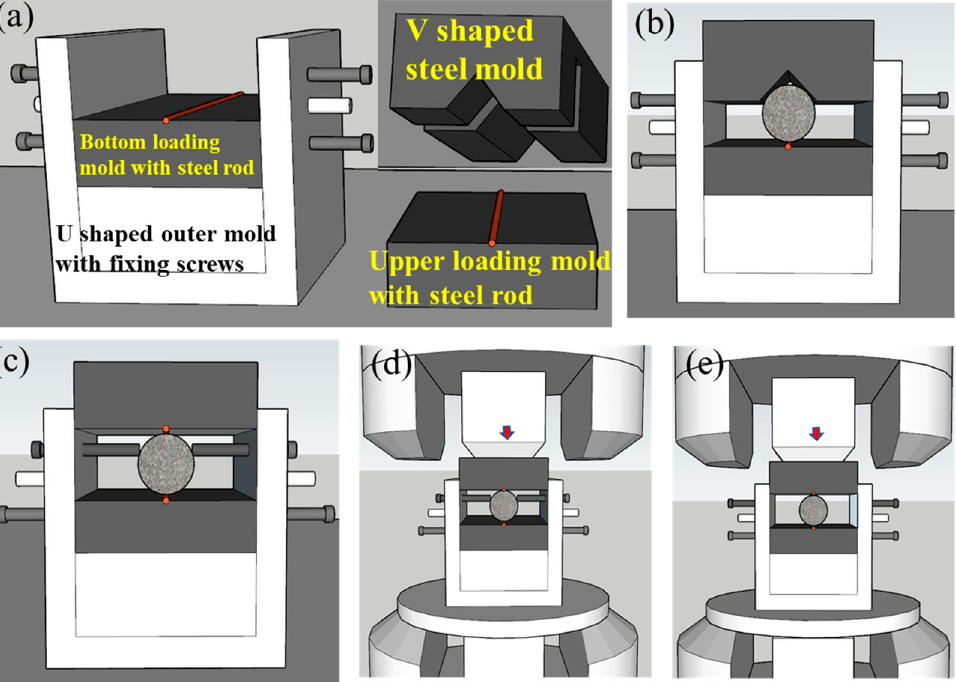
Figure 4. Composition and usage fl ow of a novel Brazil spli tt ing testing device: ( a ) U Shaped outer steel mold with fi xing screws, ( b ) V Shaped steel mold and upper loading mold with steel rod; ( c ) Install rock specimen, ( c ) Change V shaped steel mold as upper loading mode, ( d ) Install the entire mold, ( e ) Withdraw fi xing screws and loading.